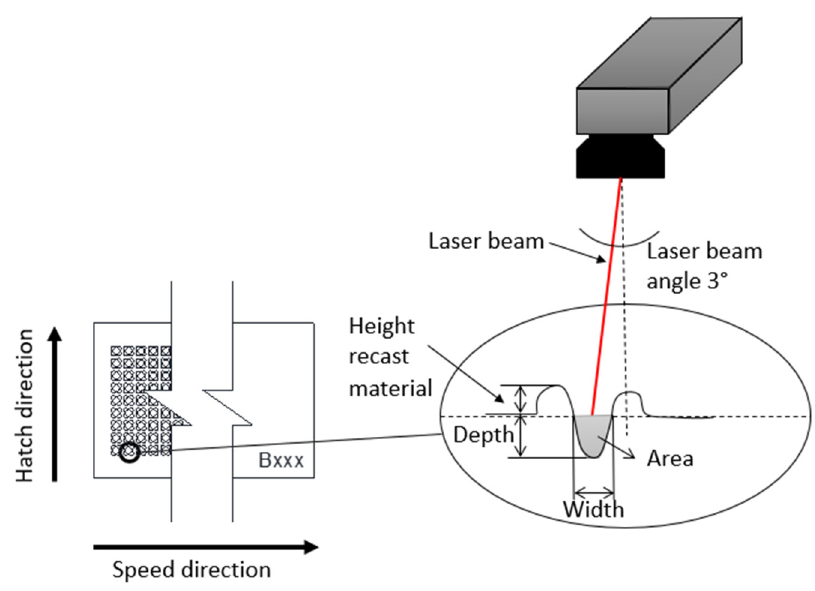
Figure 3. Geometry characterization after LST on ferritic stainless steel AISI 430.